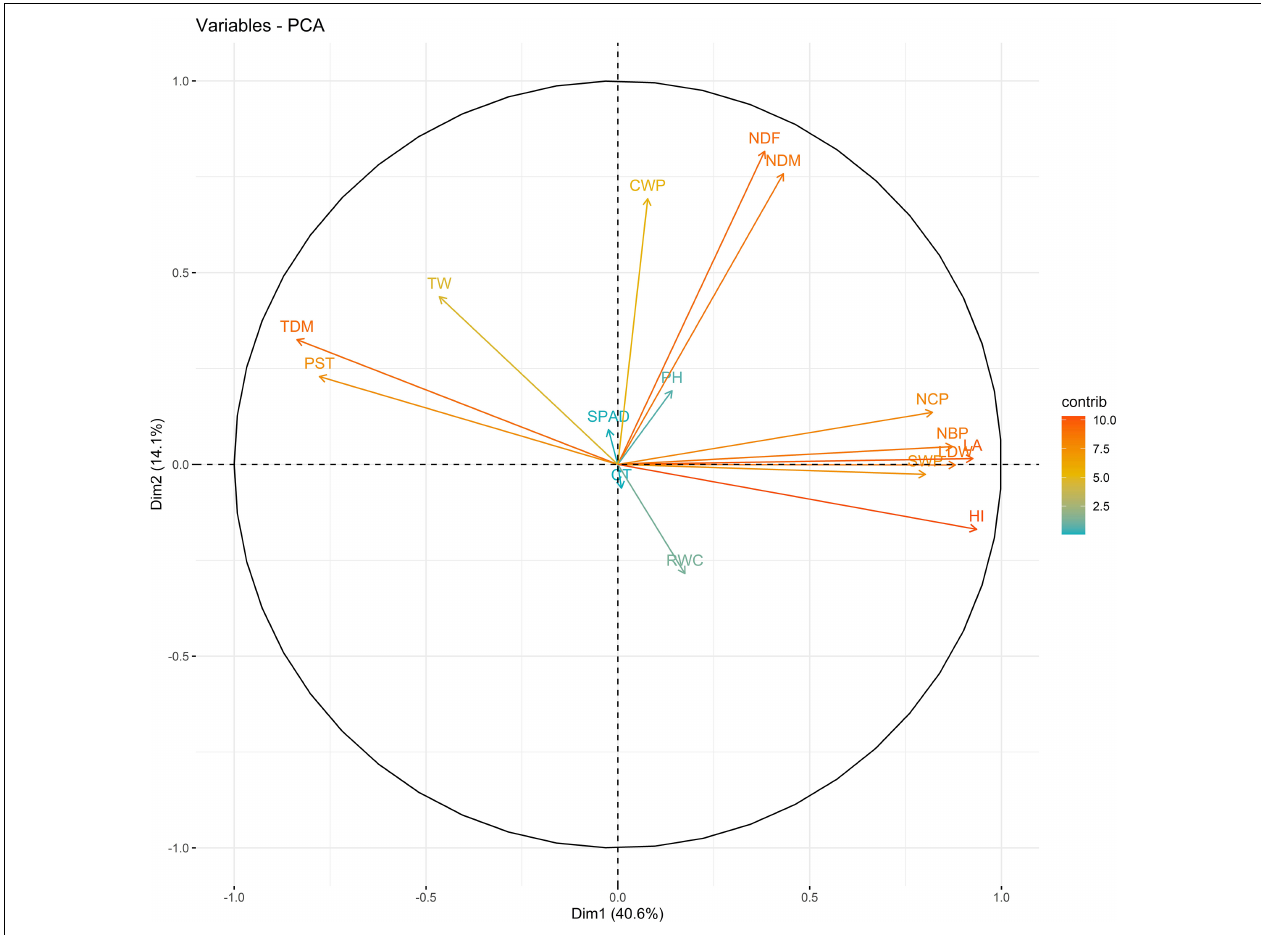
FIGURE 3 | Biplot between PC1 and PC2 showing contribution of various traits during year 2019 season under well-watered (WW) conditions.